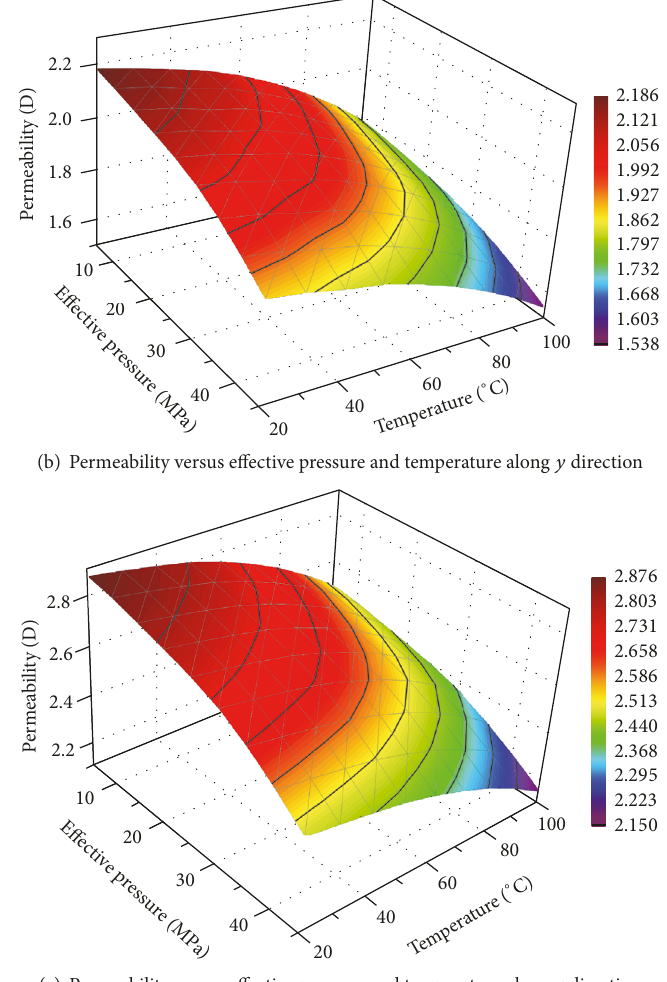
Figure 8: Permeability variation of model MS1 with effective pressure and temperature along 𝑥 , 𝑦 , and 𝑧